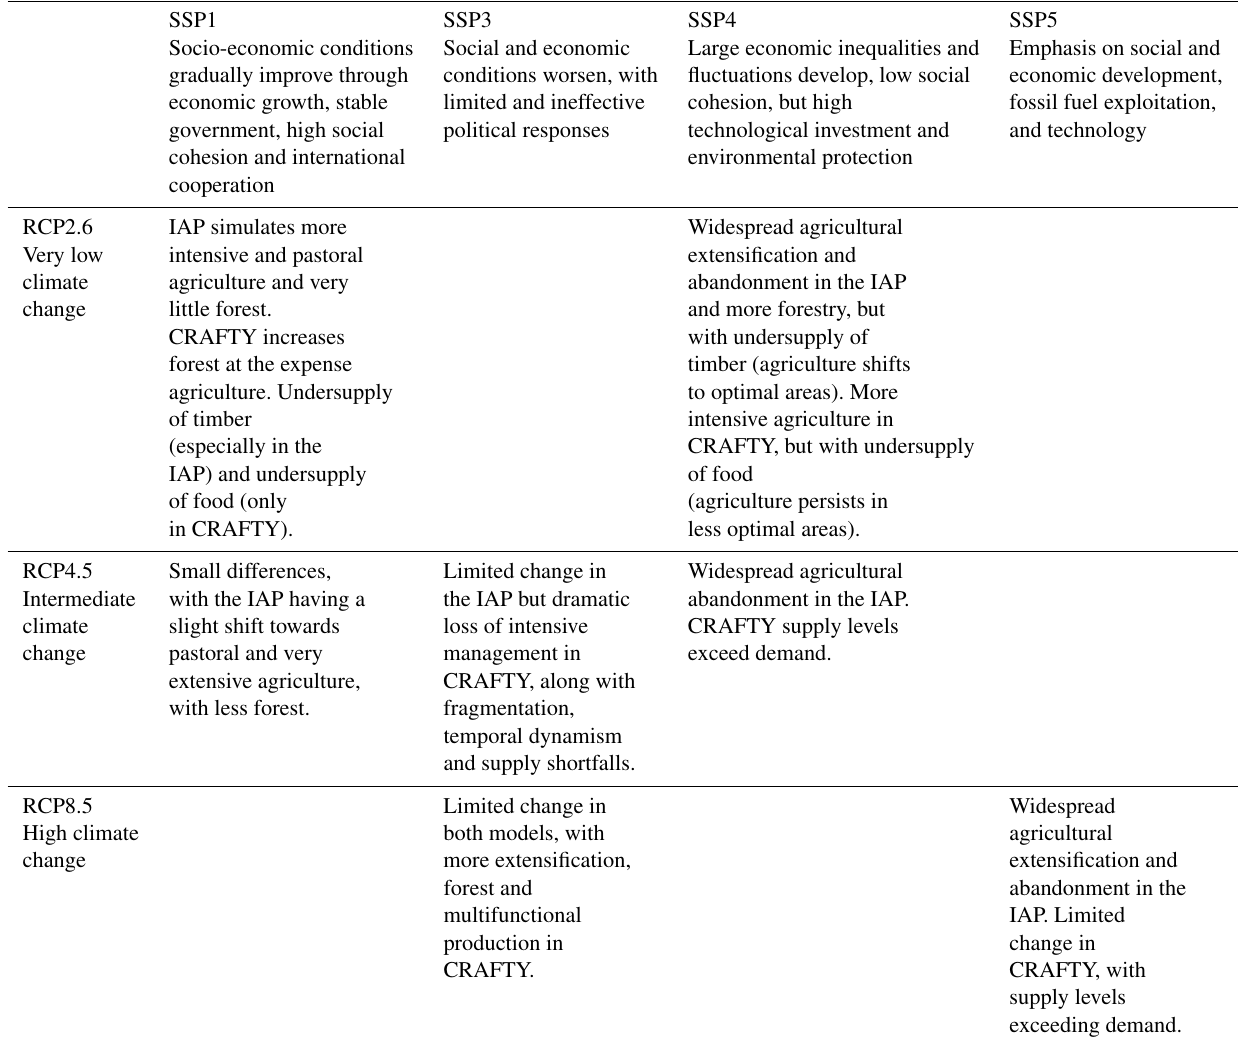
Table 1. Climatic and socio-economic scenario identities, summaries and main